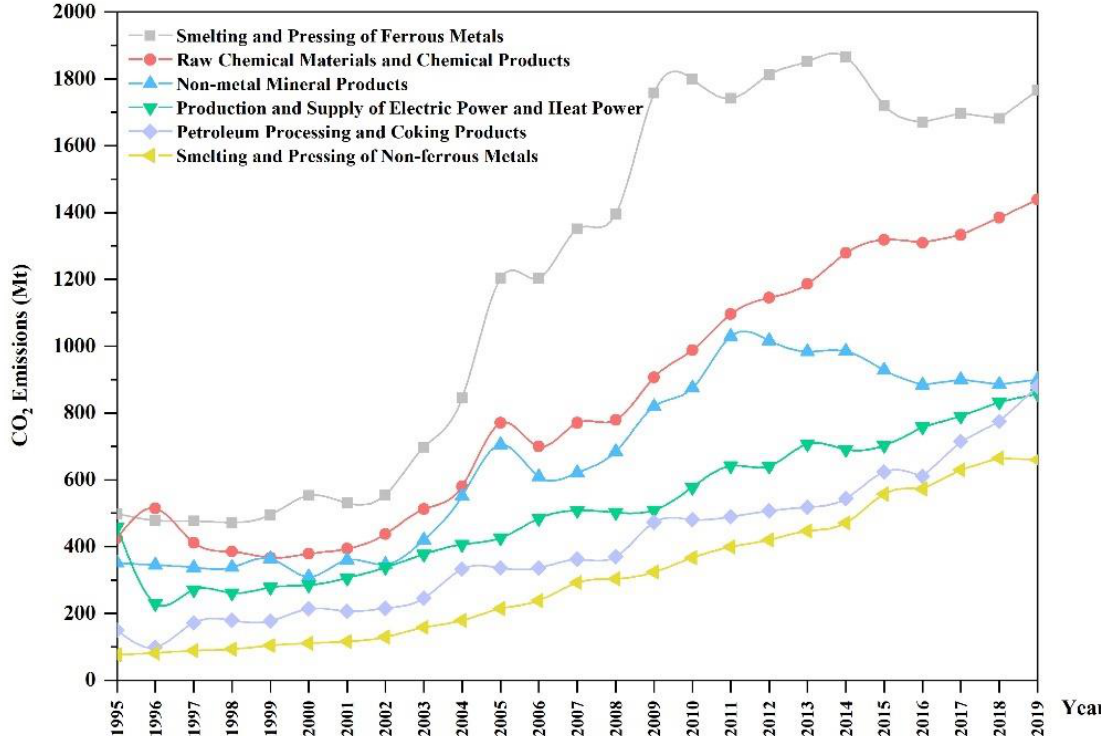
Figure 5. Changes in CO 2 emissions from the top six industrial subsectors from 1995 to 2019.